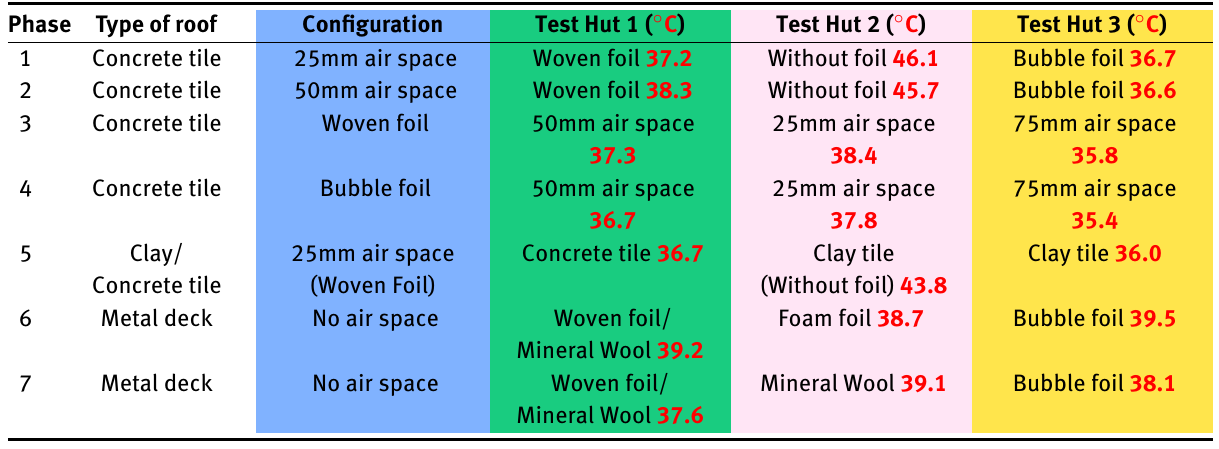
Table 3: Maximum attic air